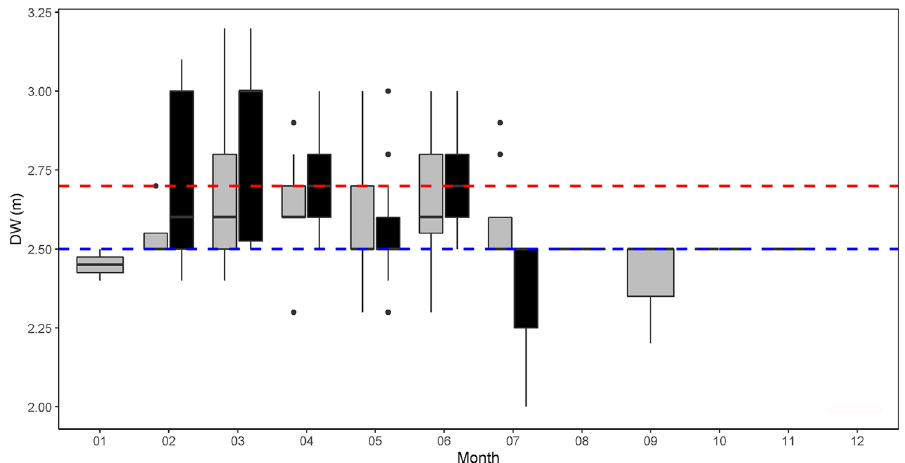
FIGURE 3 | Female (grey) and male (black) Mobula tarapacana size distribution (disk width- DW, in meters) per month, in the Saint Peter and Saint Paul Archipelago (SPSPA), from December 2008 to June 2016. Red dashed line= size at maturity for males (White et al ., 2006); blue dashed line= size at maturity for females (Notarbartolo di Sciara,